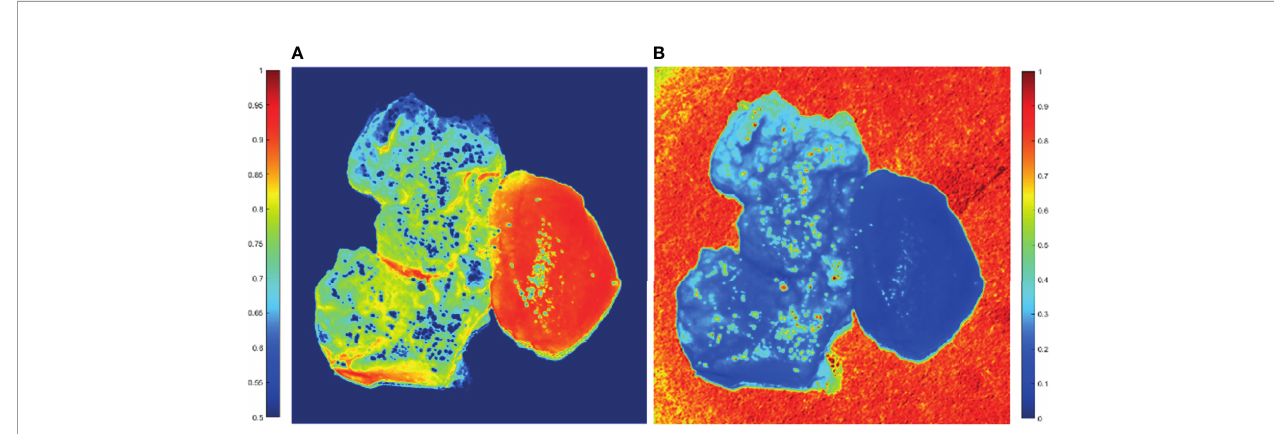
FIGURE 5 | 2D PIT images of PIT parameters of GBM samples with non-GBM brain tissue. The scale of the normalized elements is given by the color bar. (A) Parameter (1 − D ). (B) Parameter t .